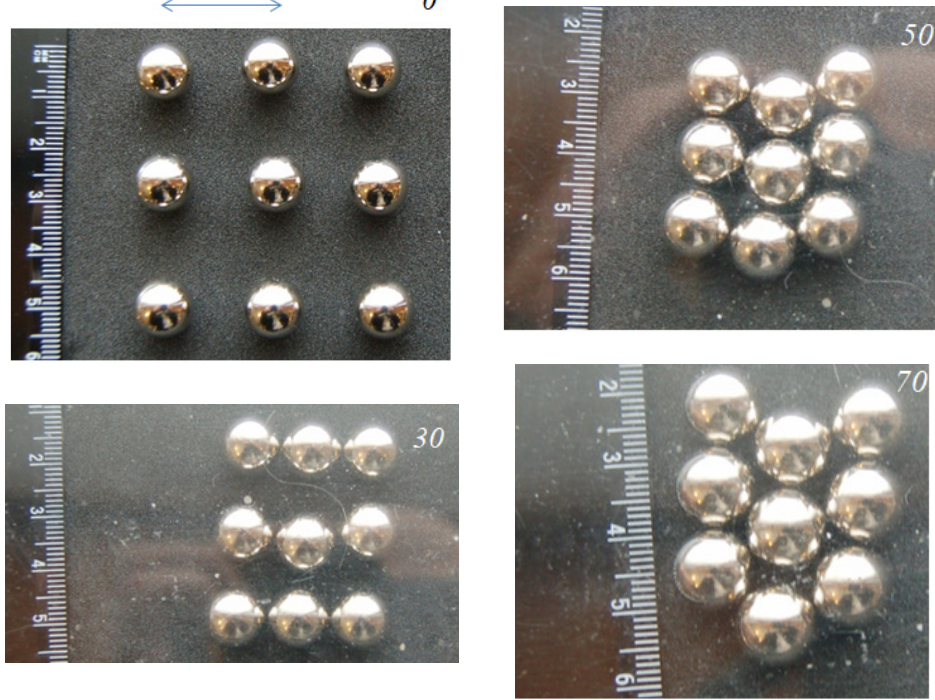
Figure 5. Nine balls at an initial distance of 20 mm from each other.